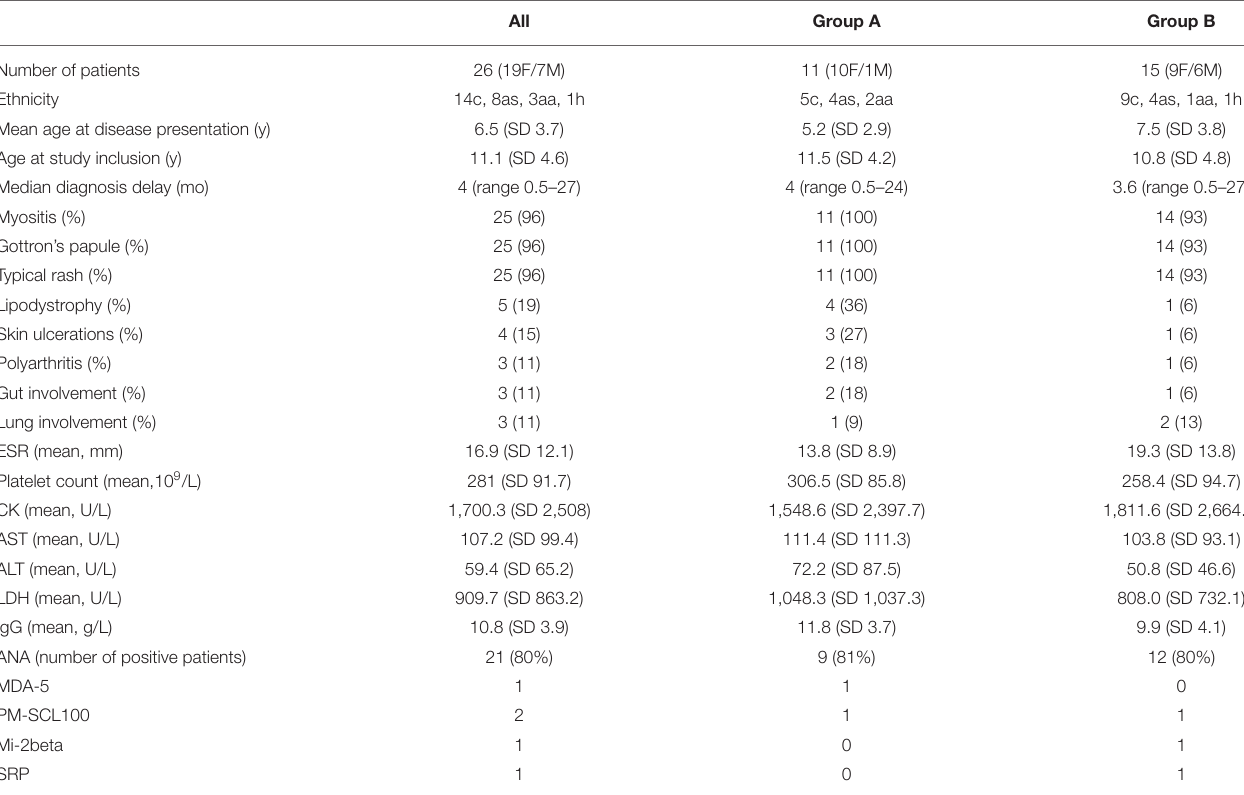
TABLE 1 | Clinical and laboratory characteristics of 26 JDM patients with anti-NXP2 autoantibodies: p values comparing Group A and B were non-significant for all variables.